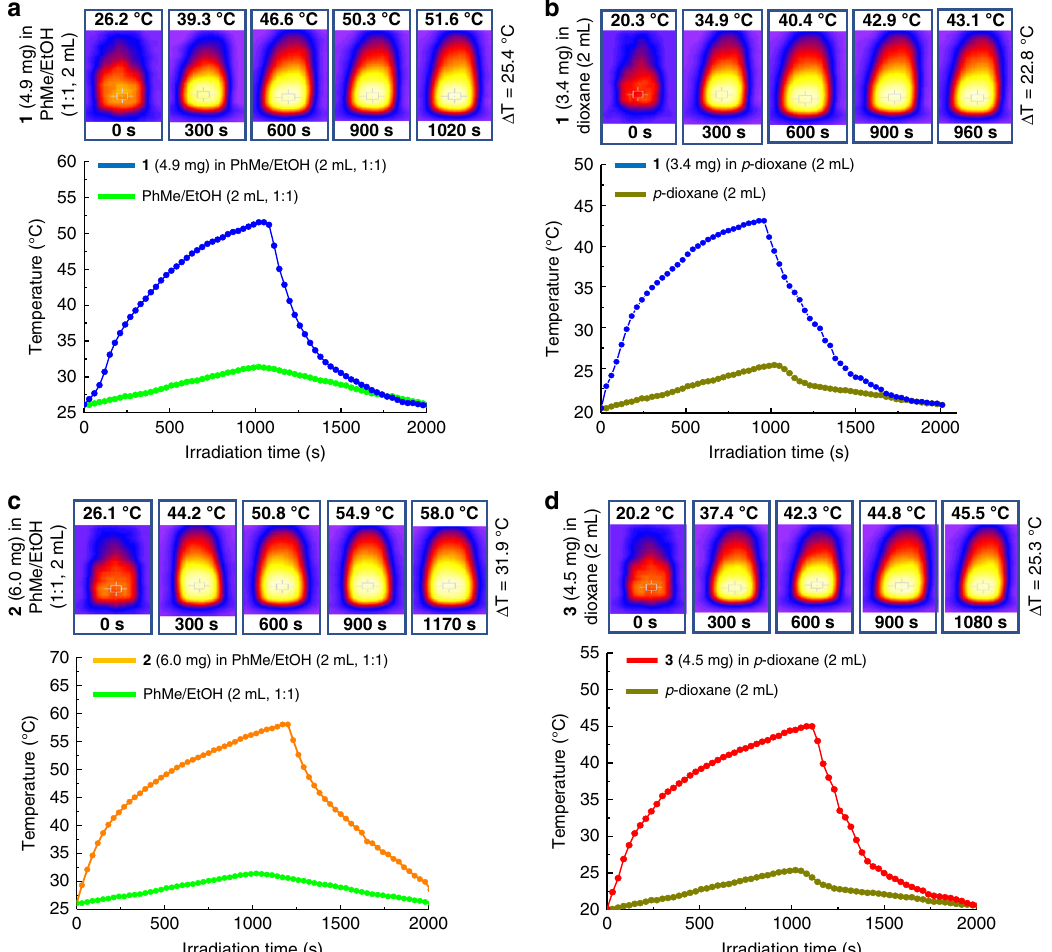
Fig. 2 Photothermal examination of 1 – 3 . a , b Photothermal behavior of 1 in PhMe/EtOH (1:1, 2 mL) and p -dioxane (2 mL), respectively. c Photothermal effect of 2 in PhMe/EtOH (1:1, 2 mL). d Photothermal effect of 3 in p -dioxane (2 mL). Visible light source: 300 W xenon lamp, λ > 400 nm with the intensity at 2.5 W cm − 2 . 4.9 and 3.4 mg of 1 are equivalent to the CCOF content in 6.0 mg of 2 and 4.5 mg of 3 , respectively